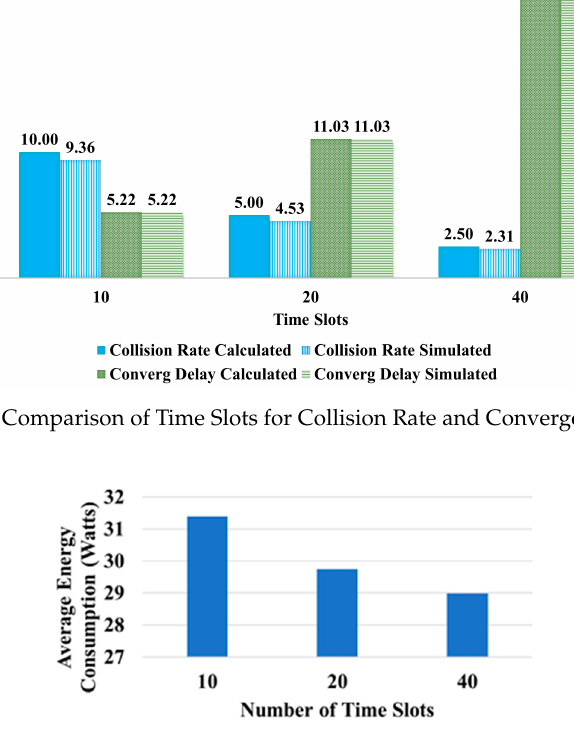
Figure 19. Comparison of Time Slots for Collision Rate and Convergence Delay.